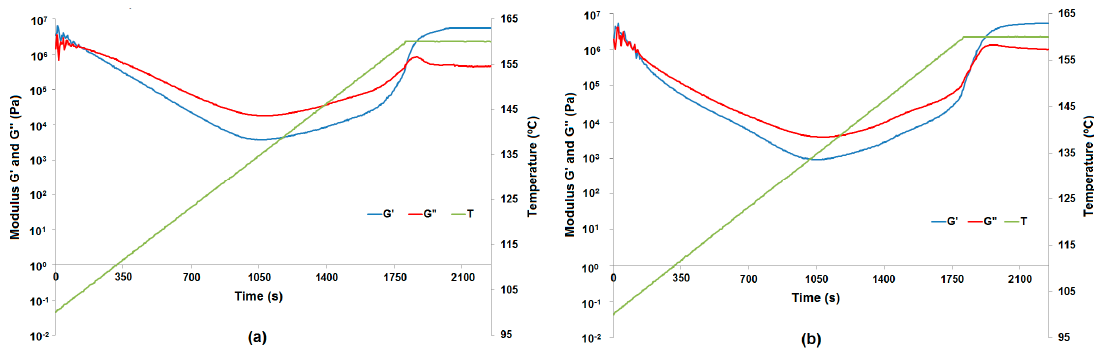
Figure 7. The curing process as complex viscosity.